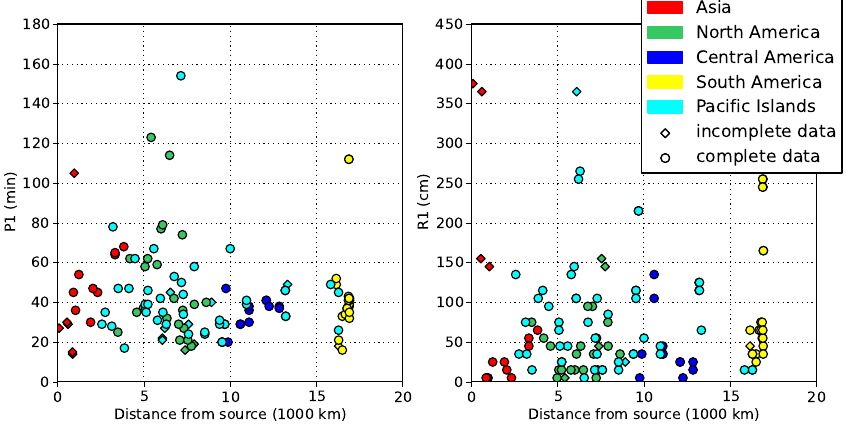
Fig. 4. Estimated period P1 (left) and range R1 (right) of the first tsunami wave plotted vs. distance from the source. Colors refer to continental regions, as in Fig. 1. Estimates from incomplete data (because of gaps or saturation in the records) are indicated with diamonds, while circles are used for all the other ones.